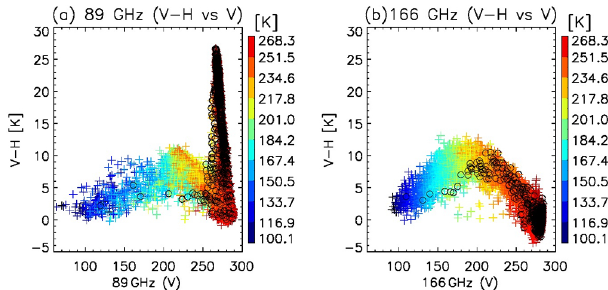
Figure 2. The PD–TB V scatter plots for the squall line case shown in Fig. 1 from 89GHz (a) and 166GHz (b) . The points are color- coded by 183.3 ± 3GHz T b . Observations over the ocean are further marked by black open